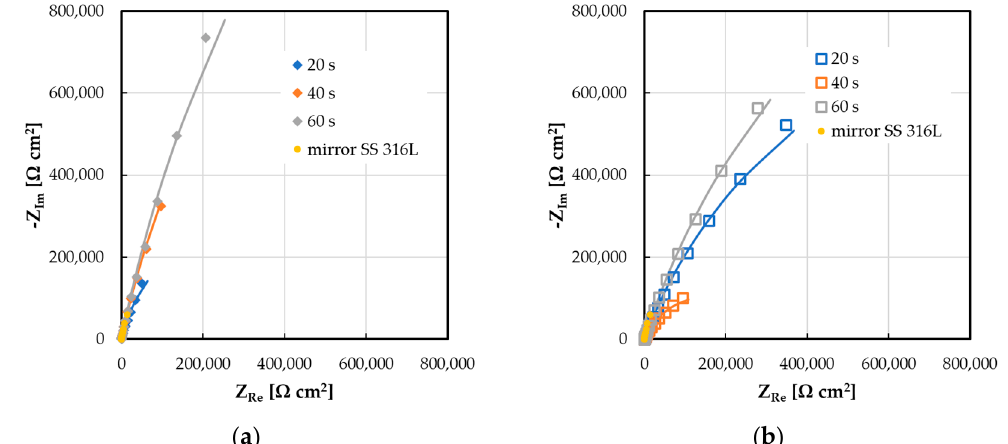
Figure 6. EIS spectra, recorded at corrosion potential, in Nyquist representation related to SS 316L samples after electrodeposition process with different treatment times. Solvent used: ( a ) DMSO; ( b ) Ethanol. Continuous lines: fitting lines.